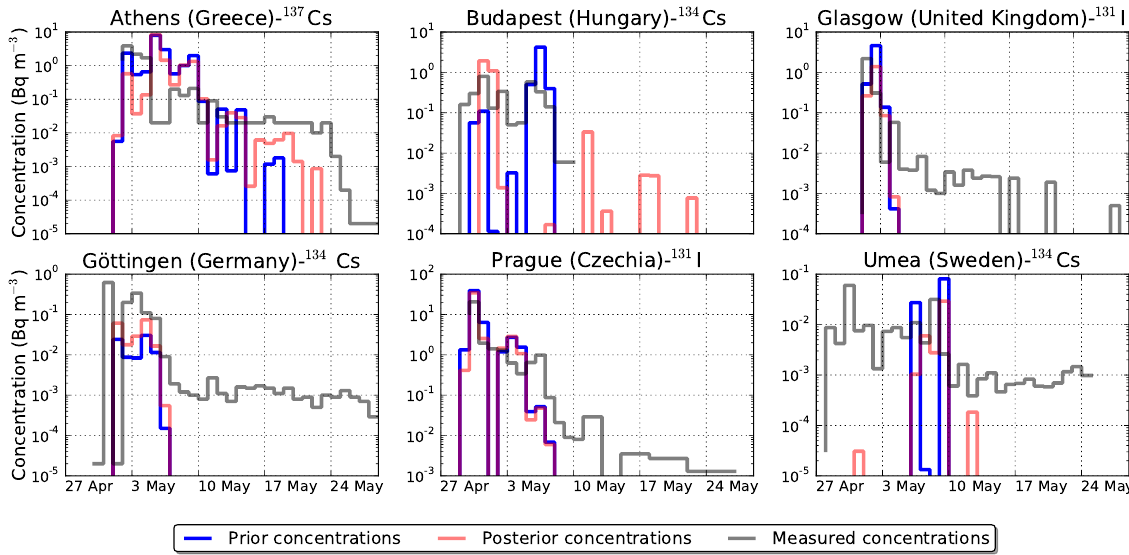
Figure 8. Time series of measured (grey) and simulated prior (blue) and posterior (red) concentrations of 134 Cs, 137 Cs and 131 I for the stations Athens (Greece), Budapest (Hungary), Glasgow (UK), Göttingen (Germany), Prague (Czechia) and Umea